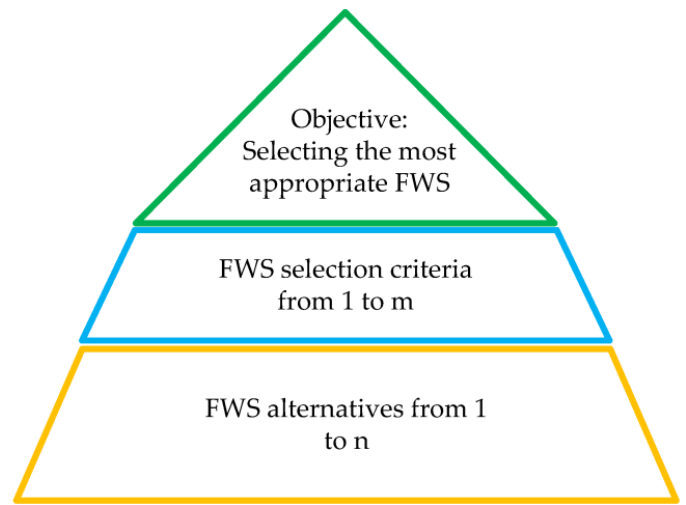
Figure 2. The general structure of the decision hierarchy.